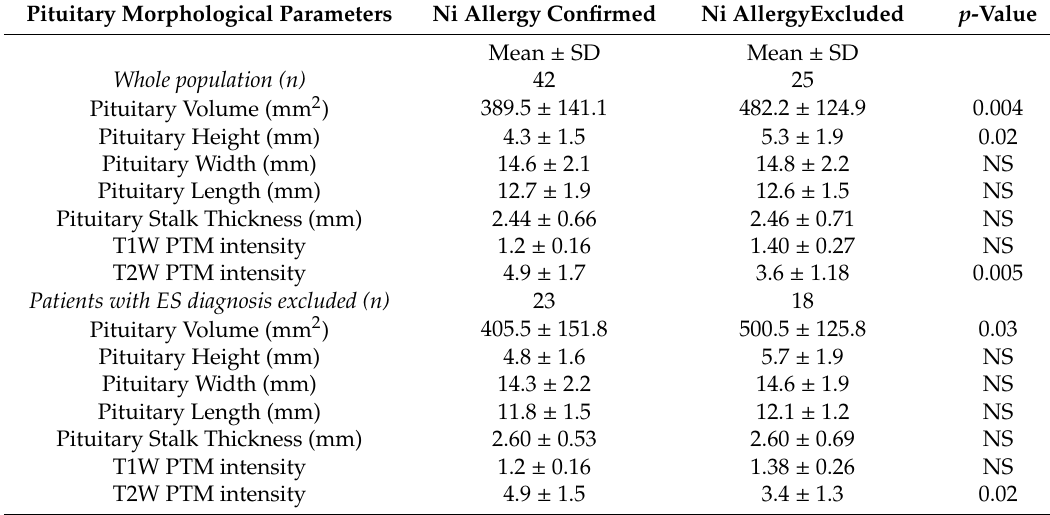
Table 3. Di ff erences in pituitary morphological parameters between Ni allergic and non-Ni allergic patients in whole population and in the subgroup of patients without empty sella (ES). Abbreviations: SD, Standard Deviation; Ni, Nickel; ES, Empty Sella; T1W PTM intensity, T1-weighted pituitary to muscular mean signal intensity; T2W PTM intensity, T2-weighted pituitary to muscular mean signal intensity; NS,